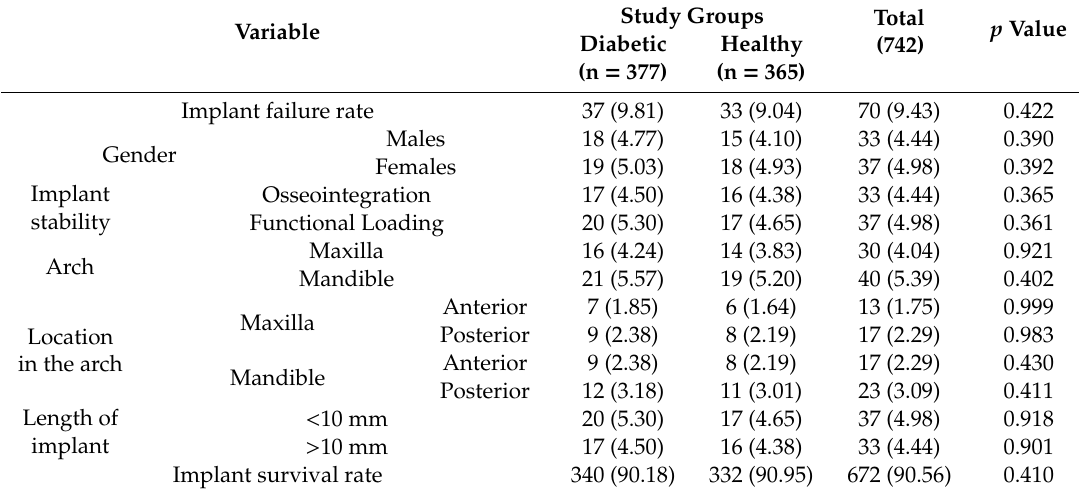
Table 3. Frequency distribution table showing descriptive and comparative evaluation of implant failure between the study